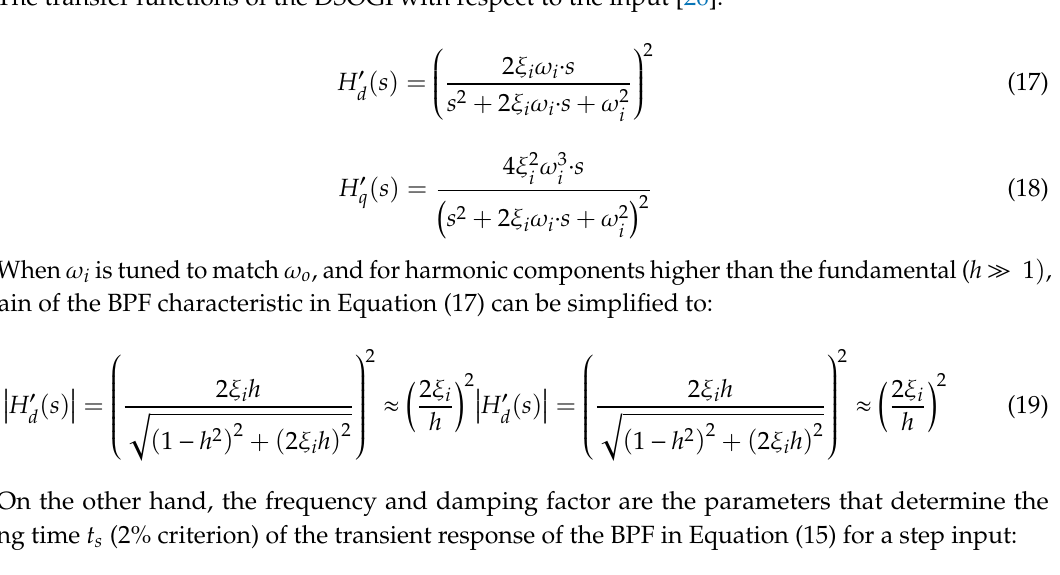
Figure 7. Block diagram of a DSOGI (double SOGI) filter as the cascading of two individual SOGIs. The transfer functions of the DSOGI with respect to the input